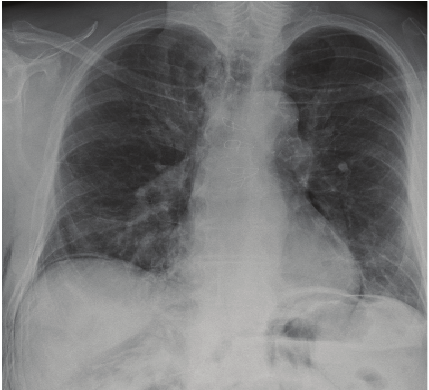
Figure 1: Intra-abdominal free air on an erect chest X-ray.